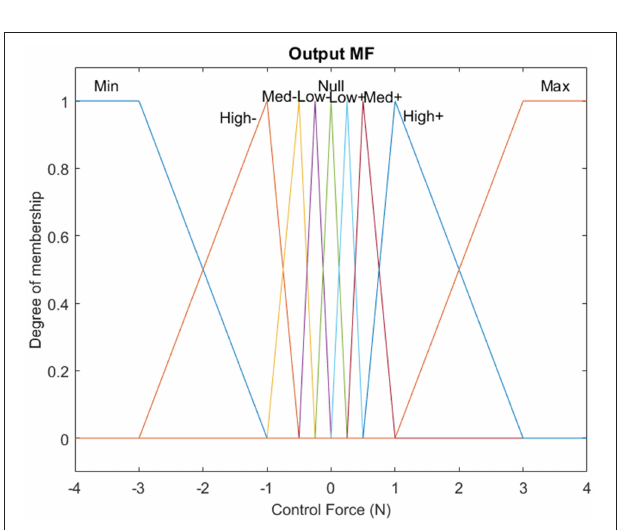
FIGURE 2 | Membership functions of input 1 (displacement) of the fuzzy controller.